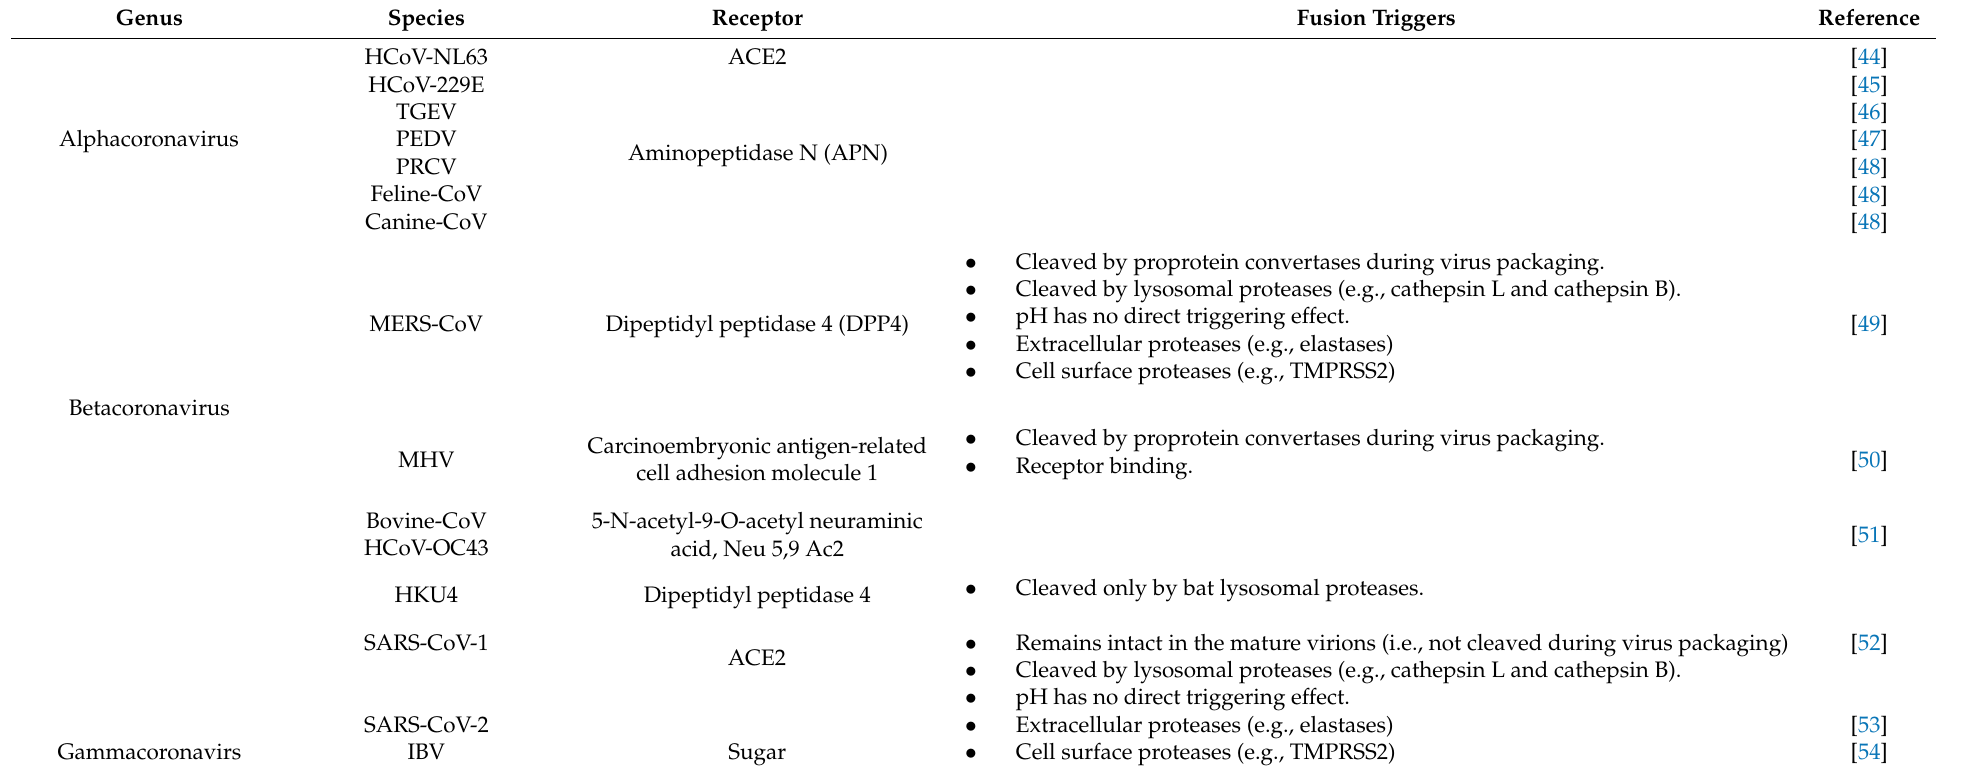
Table 1. Receptor usage and fusion triggers of most important CoVs